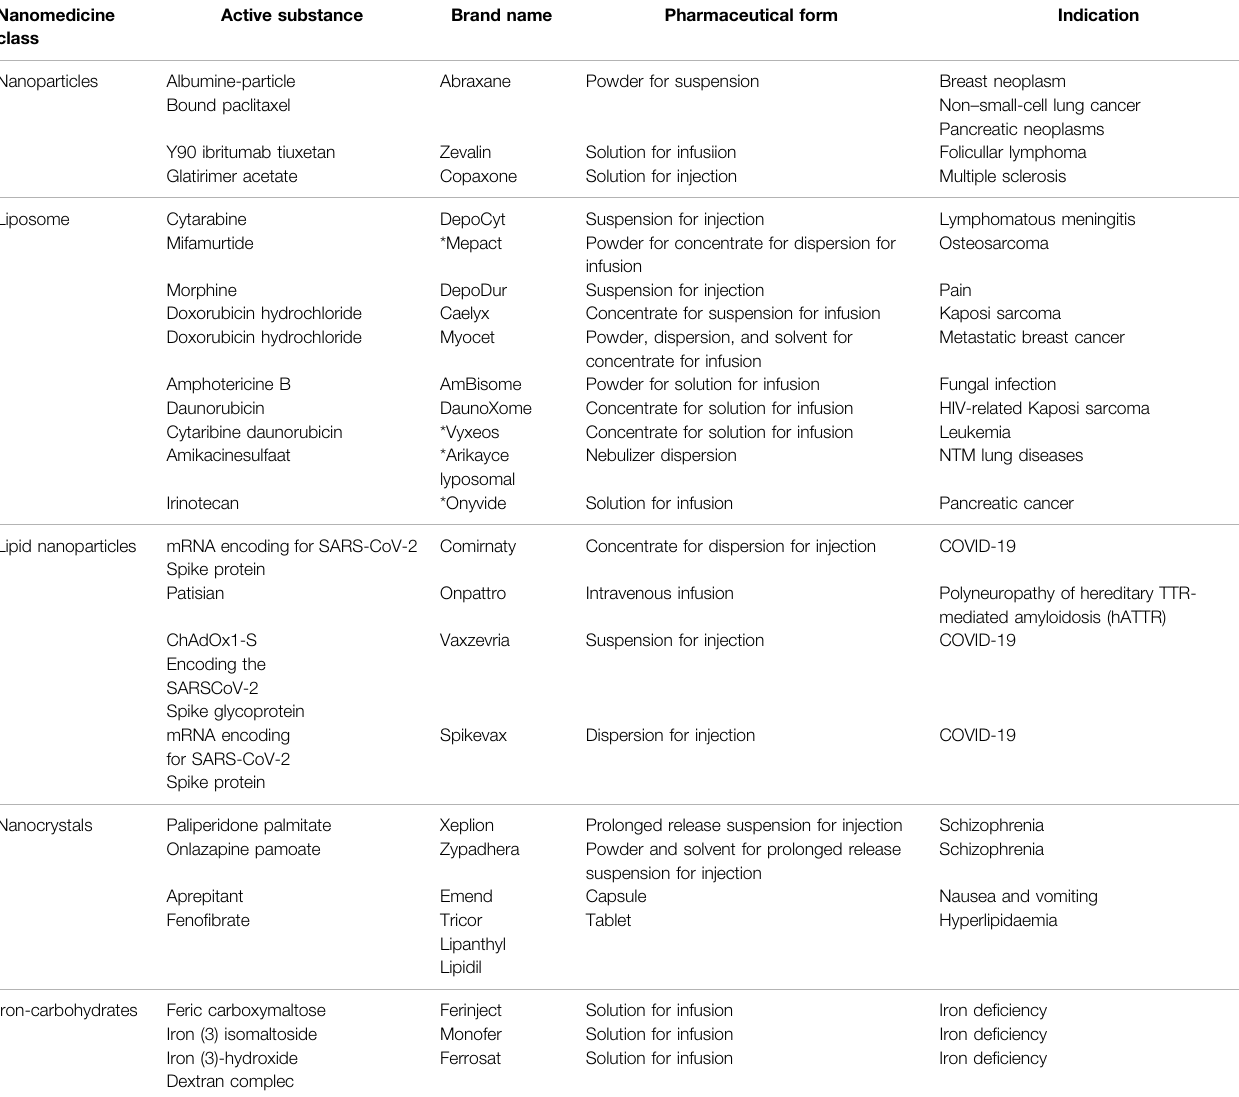
TABLE 1 | Overview of the commercially available nanomedicines in the EU (Van Trier,